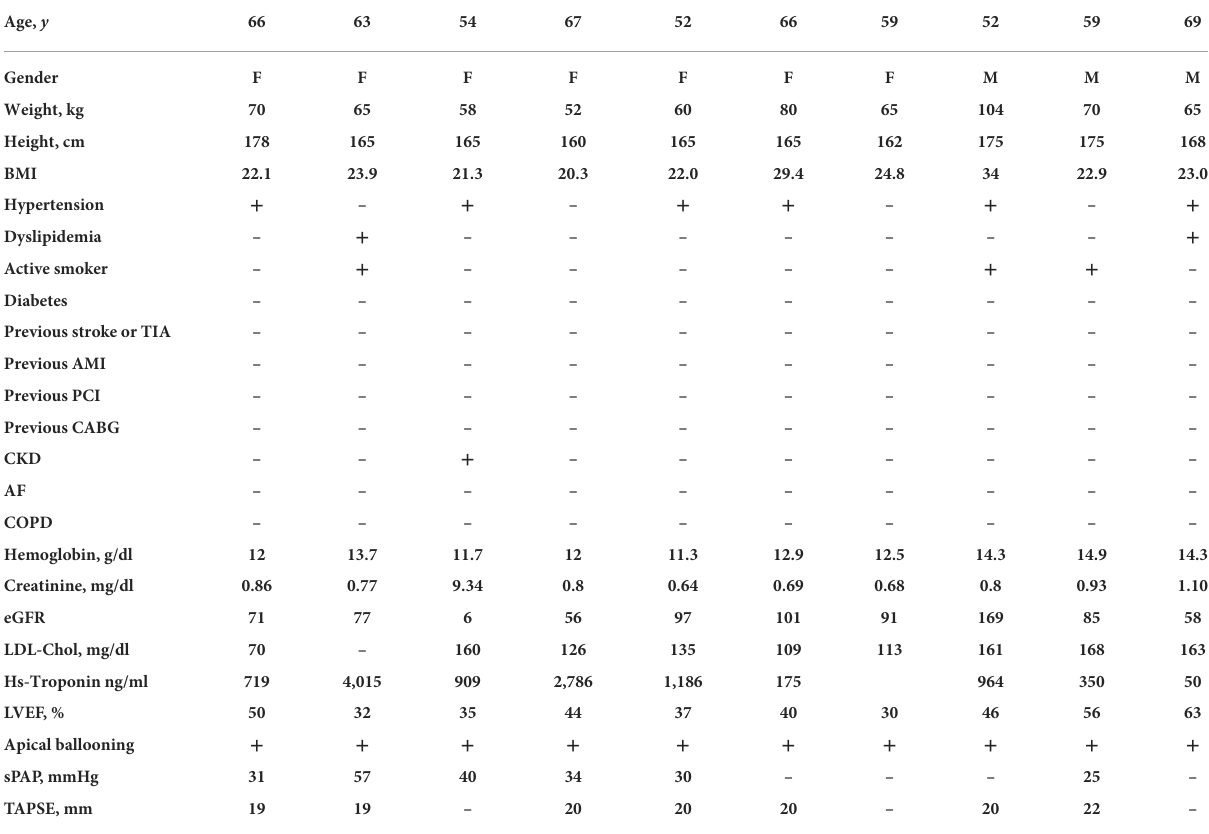
TABLE 3 Characteristics of patients with Takotsubo during semifinal and final